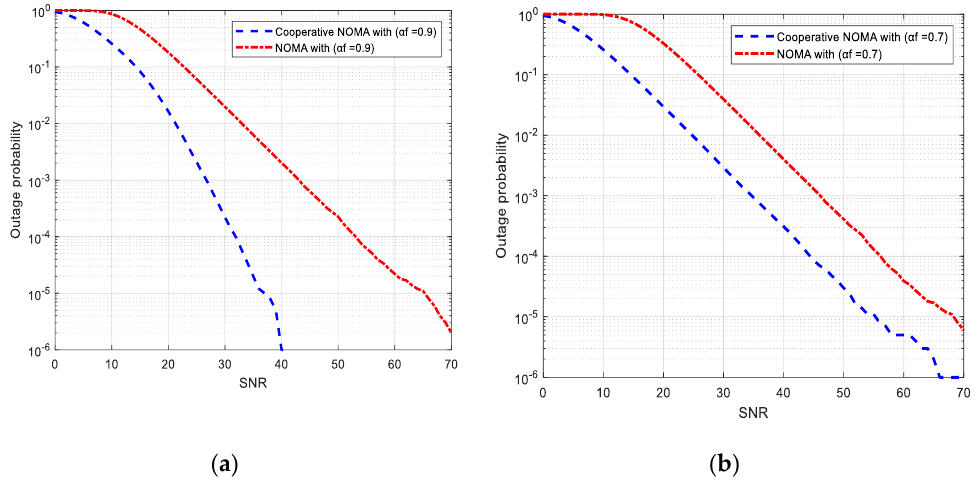
Figure 7. Outage probability against SNR for the two different users ’ DL NOMA and DL coopera- tive NOMA. ( a ) α f = 0.9 ( b ) α f = 0.7.